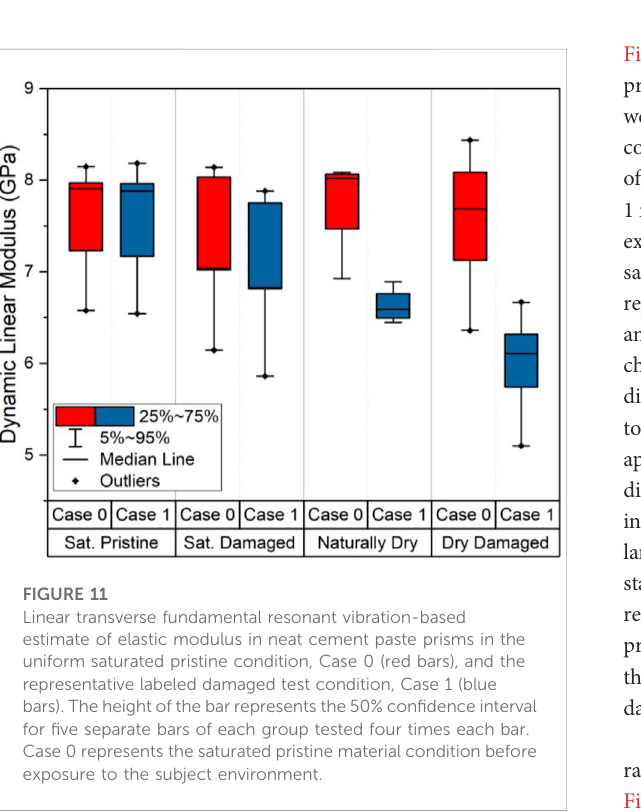
Figure 11. All samples were mature and started in the saturated